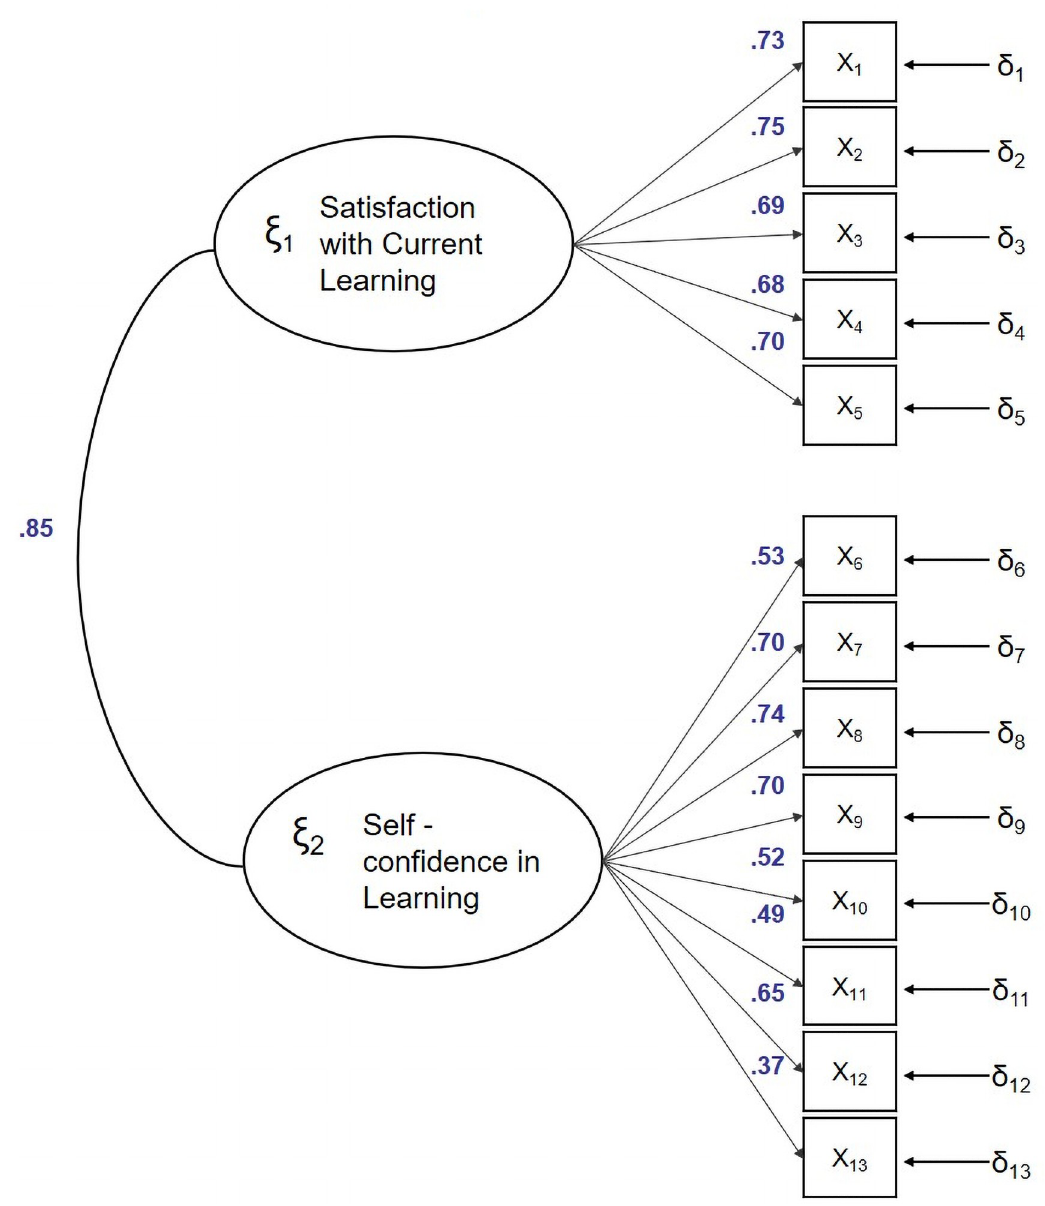
Fig 1. Standardized model